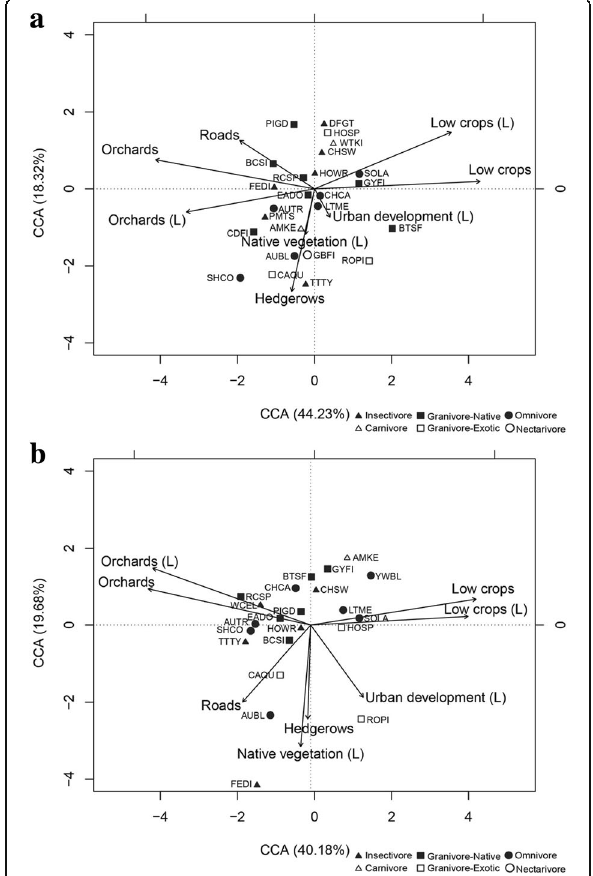
Fig. 6 Plot of the first two axes of the canonical correspondence